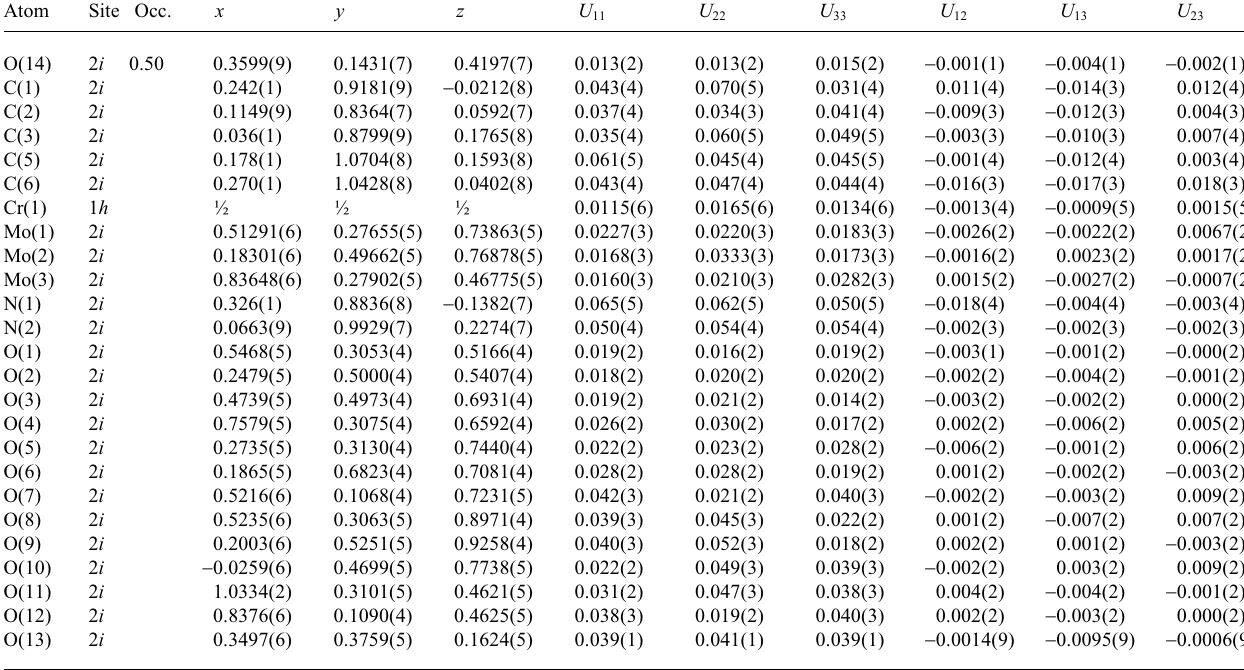
Table 3. Atomic coordinates and displacement parameters (in Å 2 ).